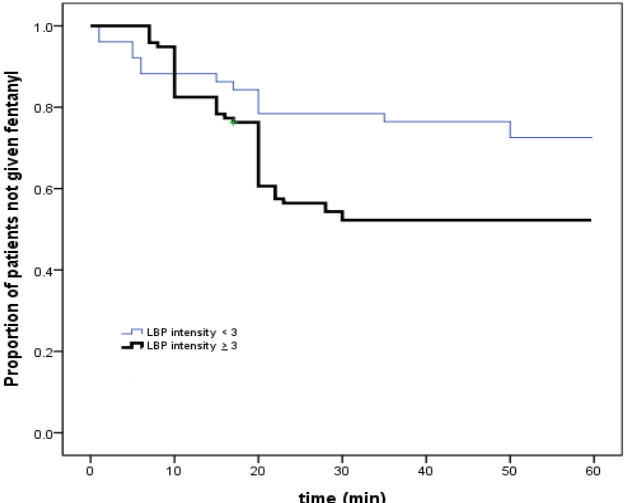
Figure 2. Opioid requirement in patients dichotomized according to preoperative lower back pain intensity. LBP, lower back